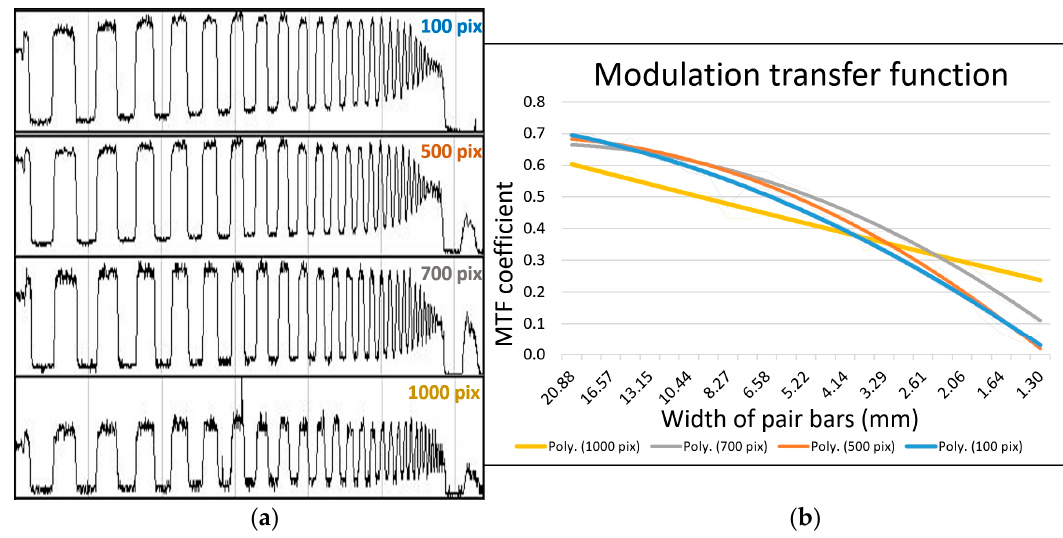
Figure 9. ( a ) Spatial frequencies of spectral profile lines for 100, 500, 700 and 1000 pixels. ( b ) Calculated